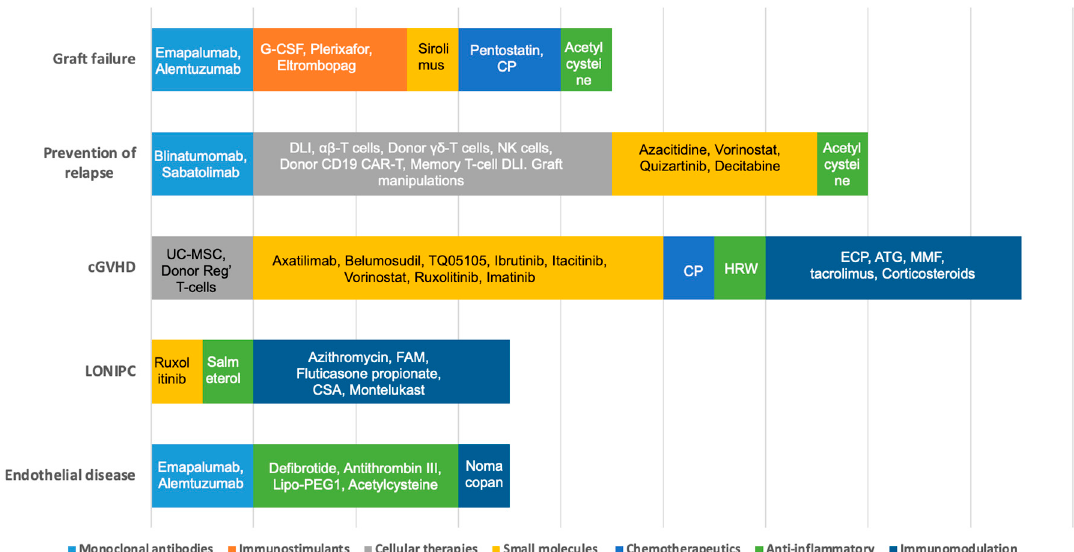
Figure 2. Strategies explored in children by mechanism of action. G-CSF: granulocyte colony-stimulating factor; CP: cyclophosphamide; DLI: donor lymphocyte infusions; NK: natural killer; CAR-T cells: chimeric antigen T cells; CIML-NK: cytokine-induced memory-like natural killer; cGVHD: chronic graft versus host disease; UC-MSC: umbilical cord mesenchymal stem cells; HRW: hydrogen-rich water; ATG: anti-thymocyte globulin; ECP: extracorporeal photopheresis; MMF: mycophenolate mofetil; FAM: fluticasone propionate, azithromycin, and montelukast sodium; CSA: cyclosporine A; TKI: tyrosine kinase inhibitor.